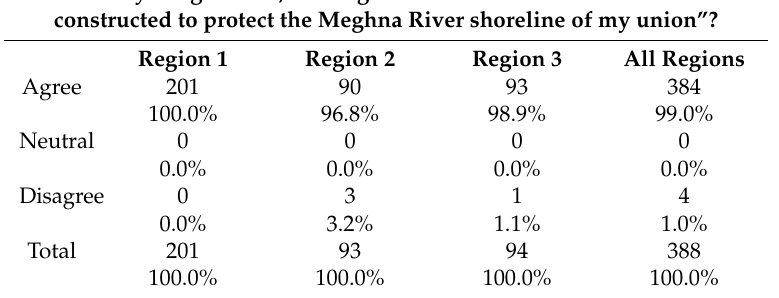
Table 12. Perception of need for revetment construction for local area and extended